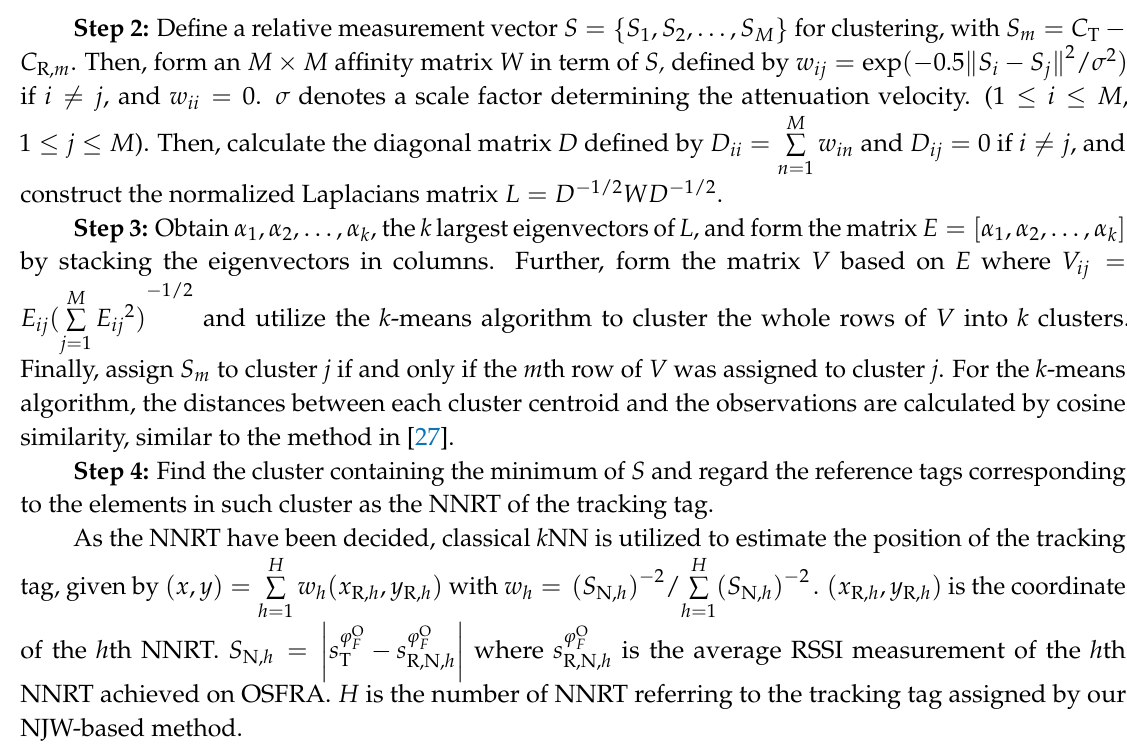
Figure 6. Schematic diagram of the symmetric ambiguity problem.